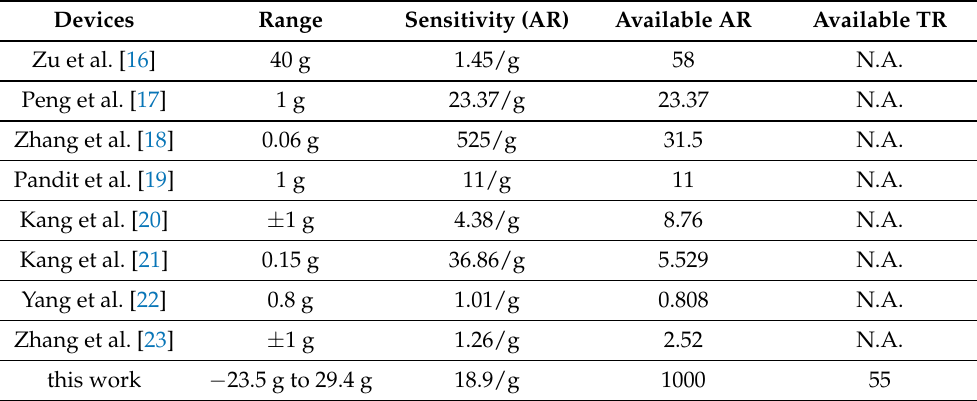
Table 2. Comparison of reported mode-localized